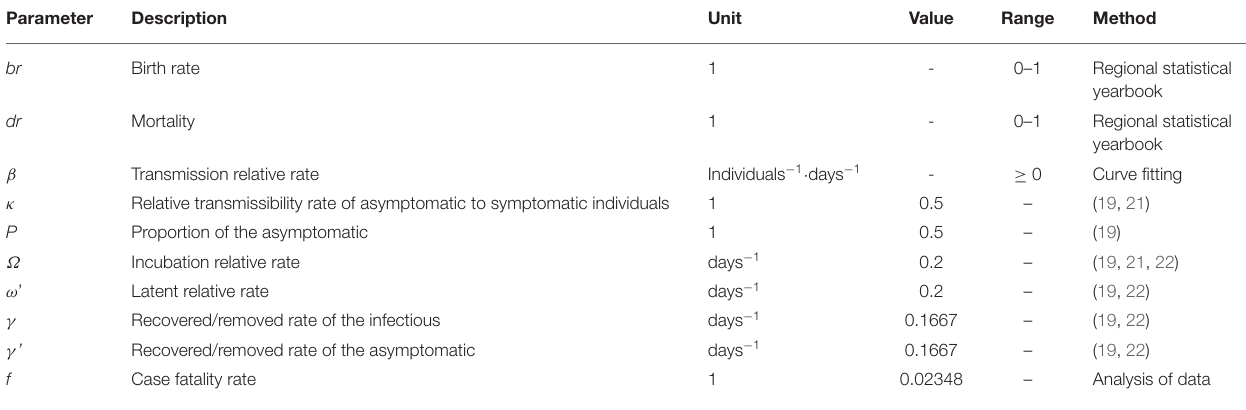
TABLE 1 | Description and values of parameters in the susceptible–exposed–symptomatic–asymptomatic-recovered/removed (SEIAR) model.